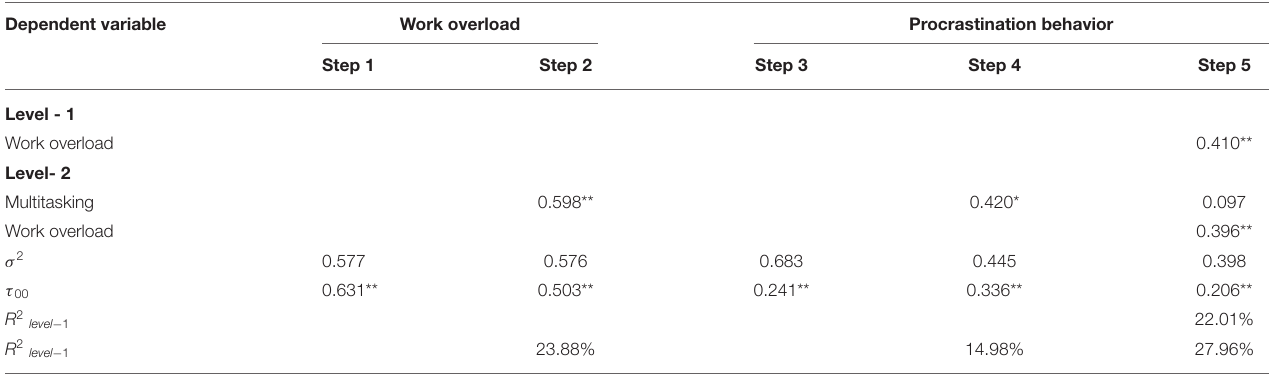
TABLE 3 | Direct and indirect effects.